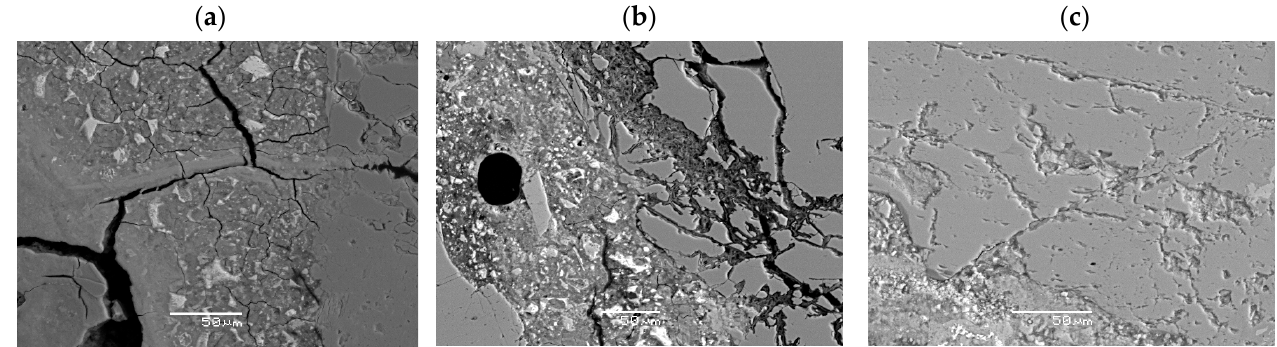
Figure 8. Cracked aggregate and ASR-gel formed in analyzed specimens: ( a ) reference, 0% of calcined clay, ( b ) 10% of clay calcined at 850 °C, ( c ) 20% of clay calcined at 850 °C.